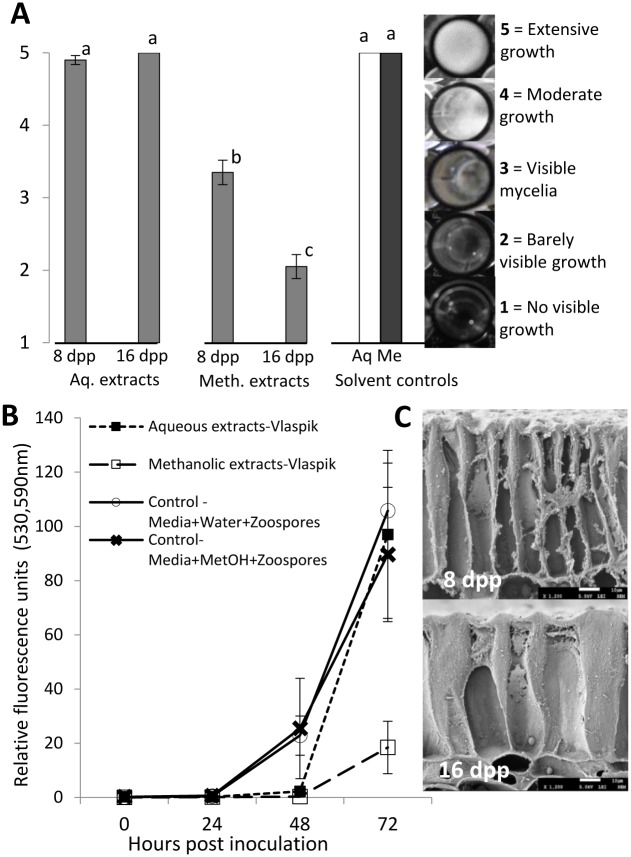
Chemical and physical properties of cucumber fruit peel at 8 and 16 days post pollination (dpp).(A, B) Effect of aqueous and methanolic extracts from cucumber fruit peel on growth of Phytophthora capsici
in vitro. Media in individual wells were treated with 10 μl methanolic or aqueous extracts of cucumber fruit peel or solvent controls prepared as described in methods and inoculated with 20 μl of zoospores at 105 zoospores ml-1. (A) Visual growth rating of isolate OP97 in response to extracts from 8 dpp and 16 dpp fruit peels, 3 days post inoculation. Rating was based on a 1–5 scale as illustrated in the sidebar. (B) Fluorescence emission from isolate NY0664-1RFP in response to aqueous and methanolic extracts. Each value is the mean of 4–5 replicate samples ± S.E. Bars marked with different letters are significantly different (LSD, P<0.05). Each experiment was performed twice with equivalent results. (C) Surface of cucumber fruit at 8 and 16 dpp. Magnification = 1200x; white bar = 10 microns.